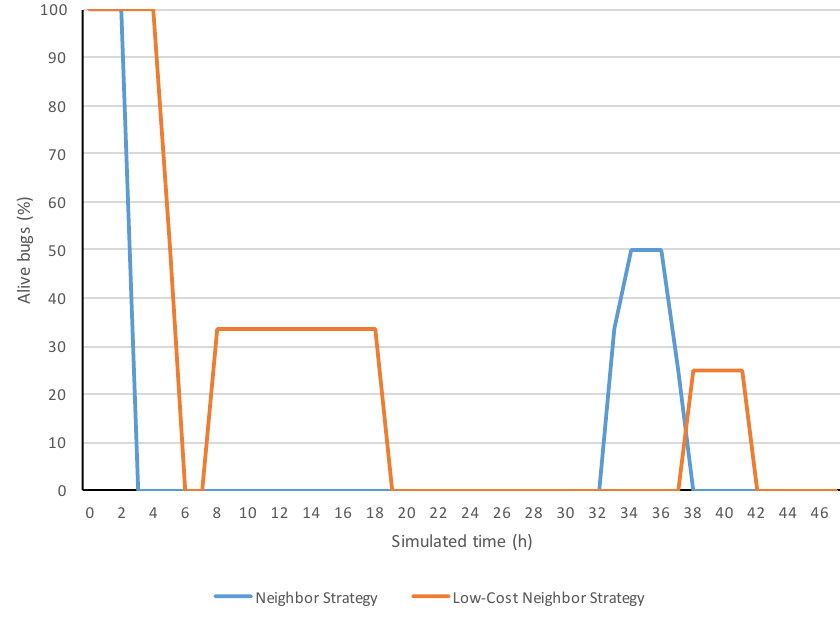
Figure 8. Simulation evolutions of the percentage of alive bugs.